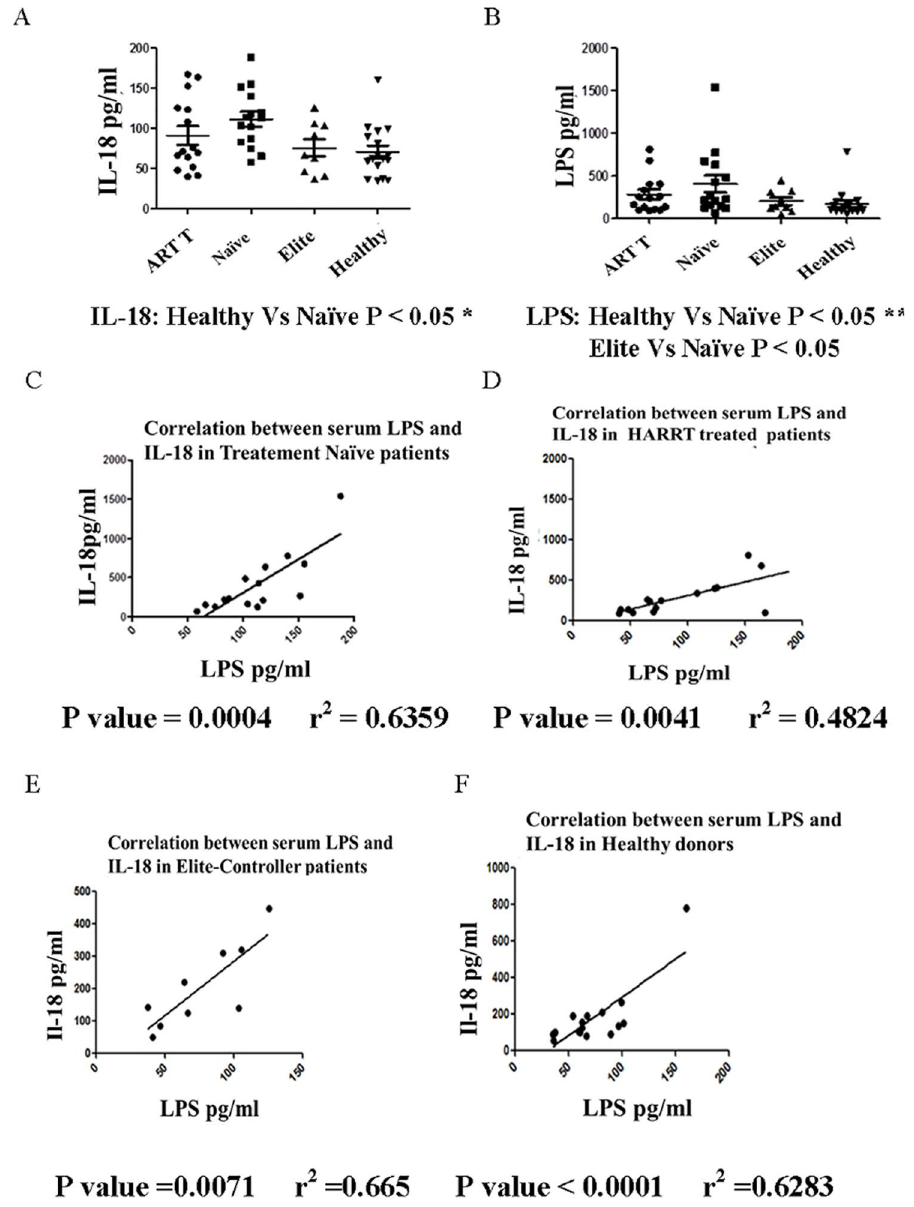
Fig 13. Correlation between serum IL-18 and LPS concentrations in HIV-infected and healthy control subjects. Concentrations of serum IL-18 (A ) and LPS ( B ) in different groups of HIV-infected individuals. The vertical lines show medians ± SD. The other panels show correlation between the two parameters in treatment-naïve HIV-infected ( C ), HAART-treated HIV-infected ( D ), Elite-Controller ( E ), and HIV-seronegative healthy control individuals ( F ).